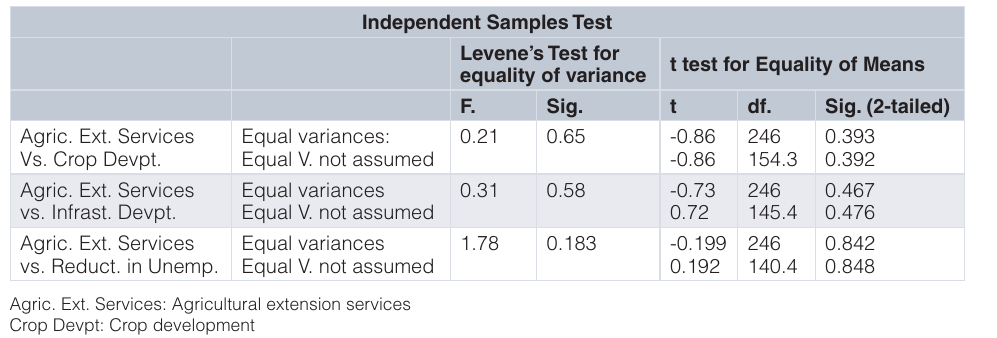
Table 6. Respondents’ perception and sex.